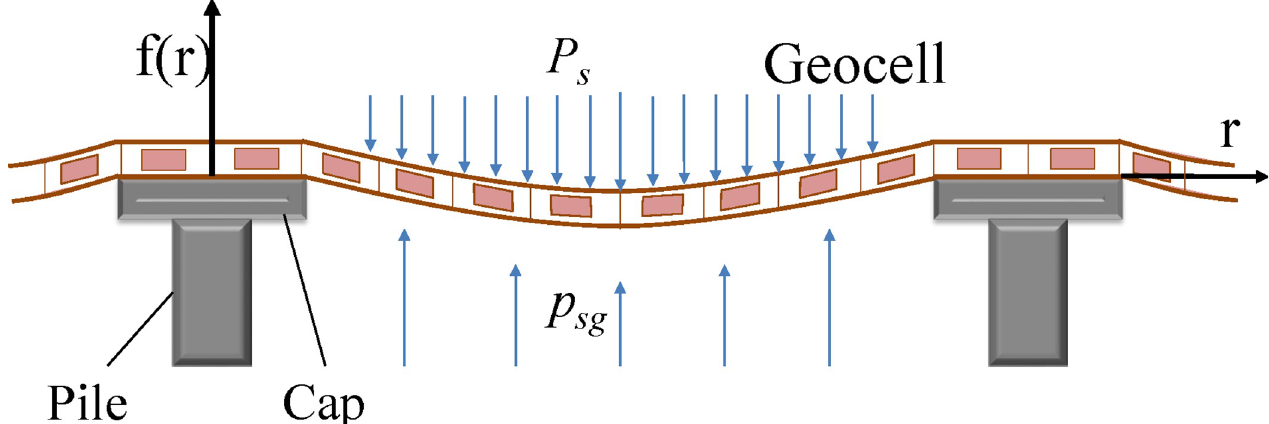
Fig 2. Schematic diagram showing stress of soil between piles for a GRPSE system with multi-layers of GR.